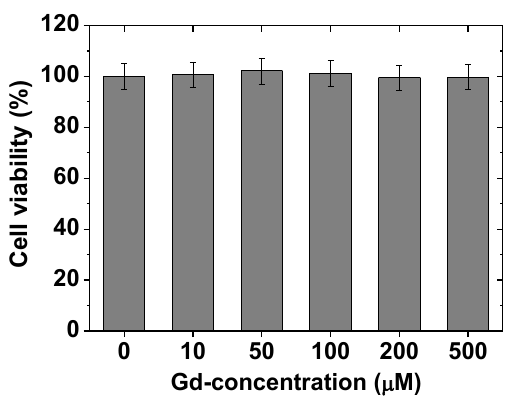
Figure 4. In vitro cellular cytotoxicity results of the PMVEMA-coated ultra-small Gd 2 O 3 NPs in DU145 cells, showing negligible cellular toxicities at Gd-concentrations as high as 500 μM.